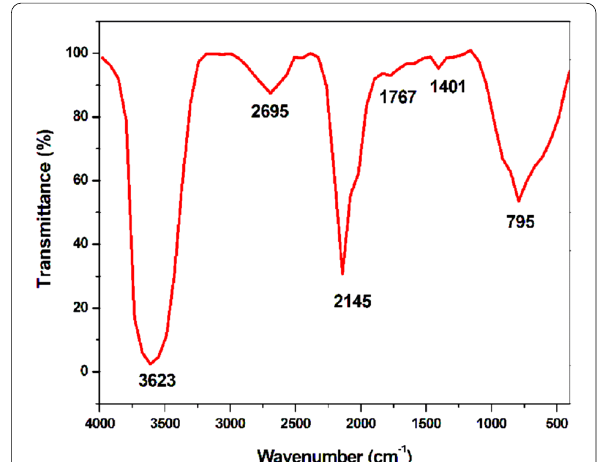
Fig. 3 FTIR spectra for the sample 1S5